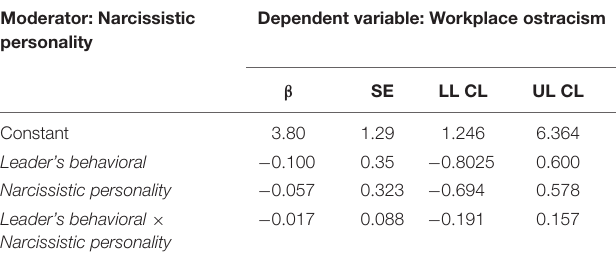
TABLE 4 | Moderation